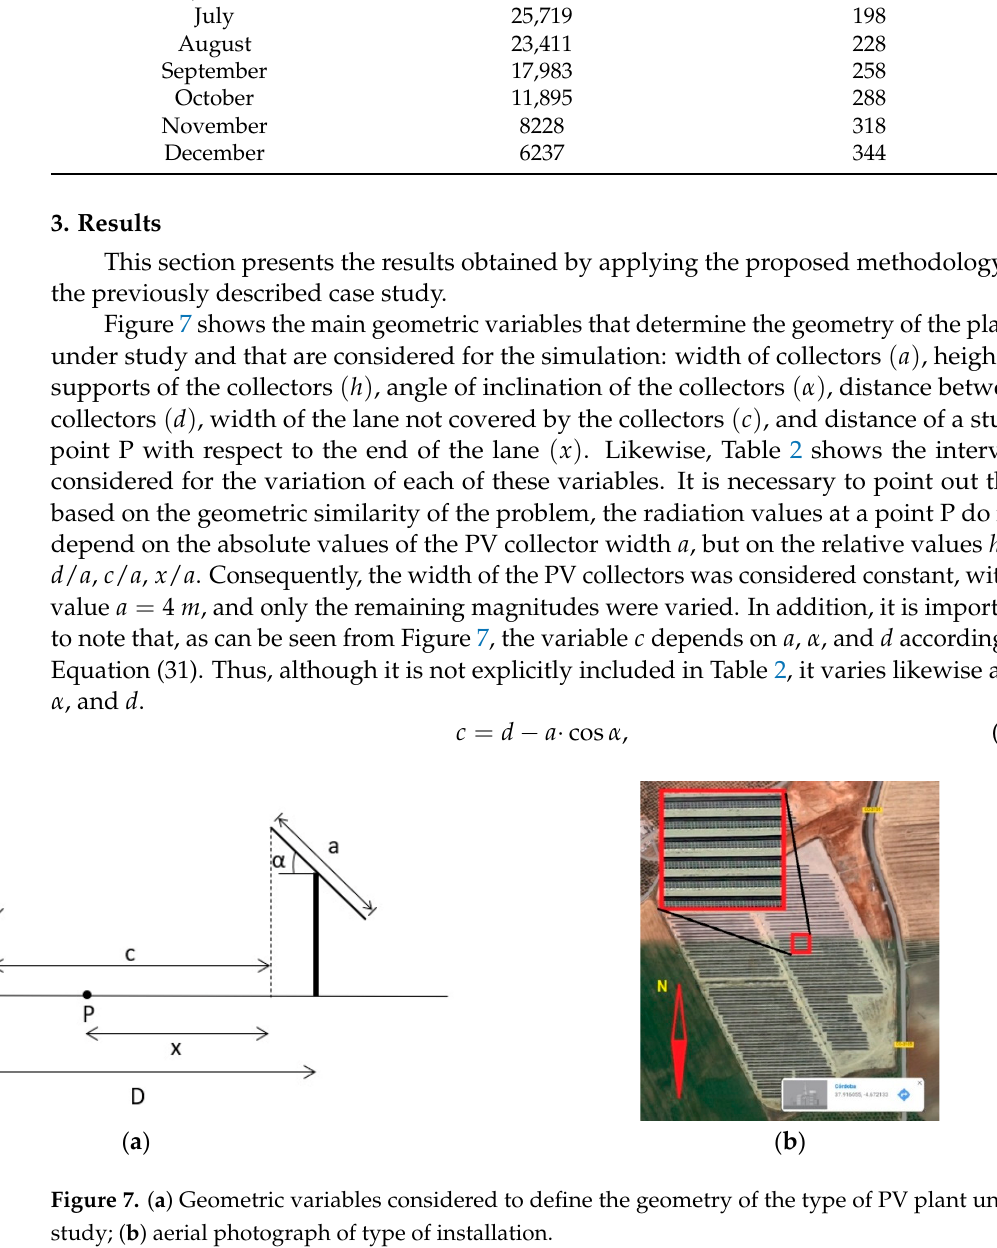
Table 2. Considered values of the design